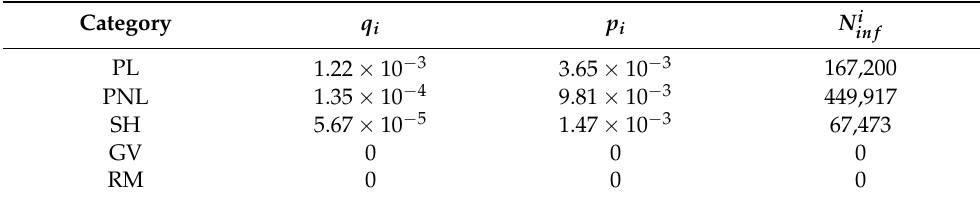
Table 6. Probability of infection following the consumption of a single serving ( q i ) and in one year ( p i ) and expected number of new infected individuals per year per food category in the Italian population ( N inf ).